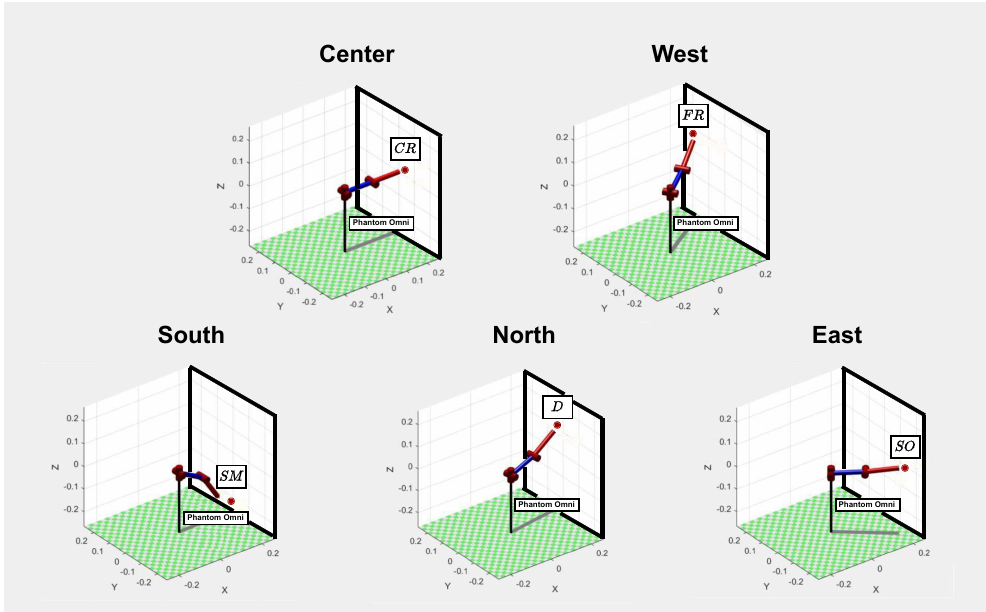
Figure 11. SD contact with texture